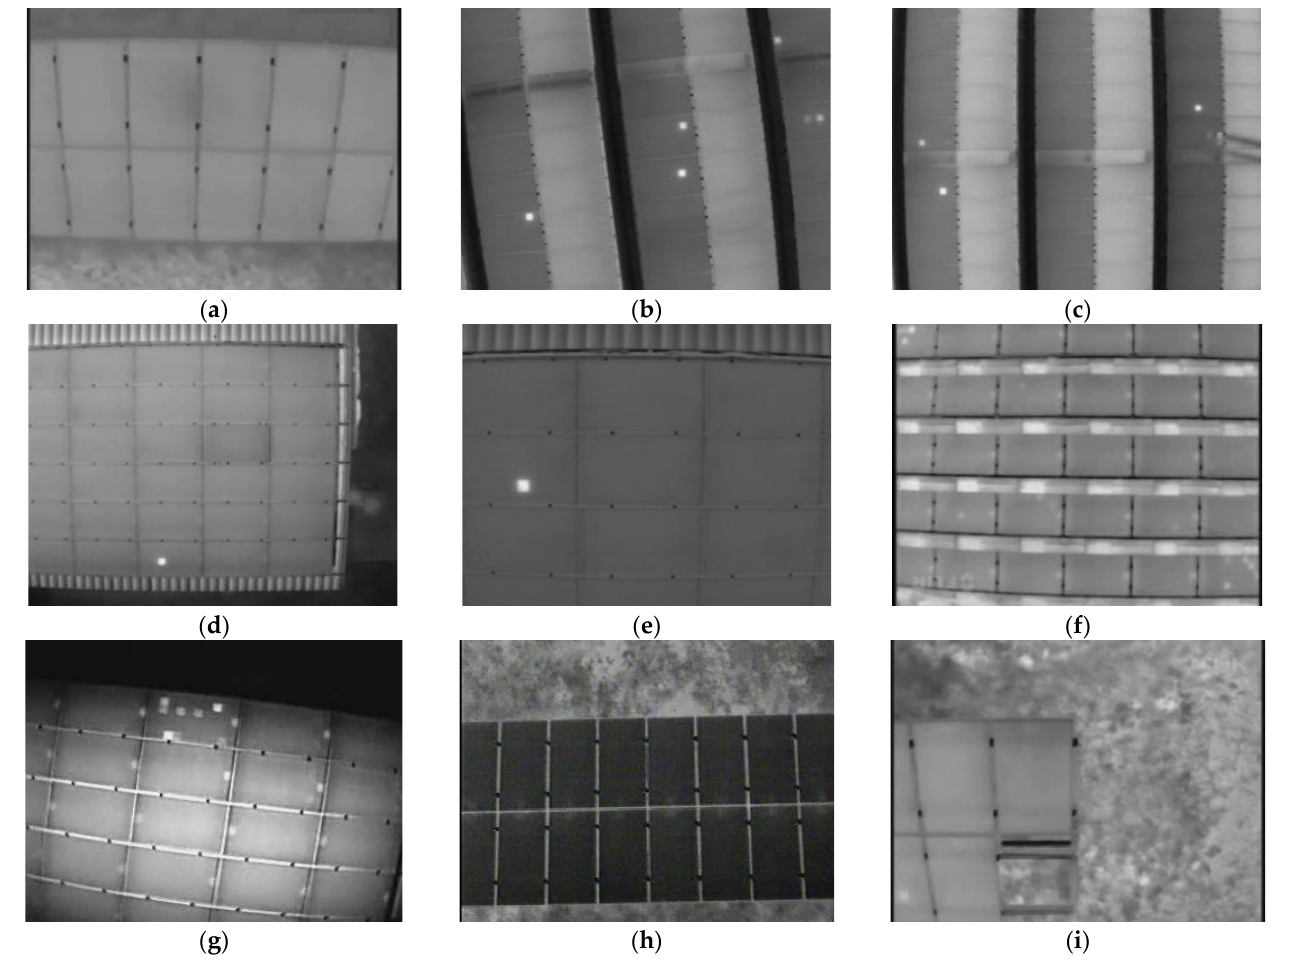
Figure 6. Partial infrared photovoltaic image dataset. ( a ) The UAV took photos along the horizontal direction of the photovoltaic panel. ( b ) The UAV took photos along the tilt angle of the photovoltaic panel. ( c ) The UAV took photos along the vertical direction of the photovoltaic panel. ( d ) Long-distance shooting. ( e ) Close-range shooting. ( a , d – g ) are different types of photovoltaic panels. ( h , i ) are different photovoltaic panel placement methods.